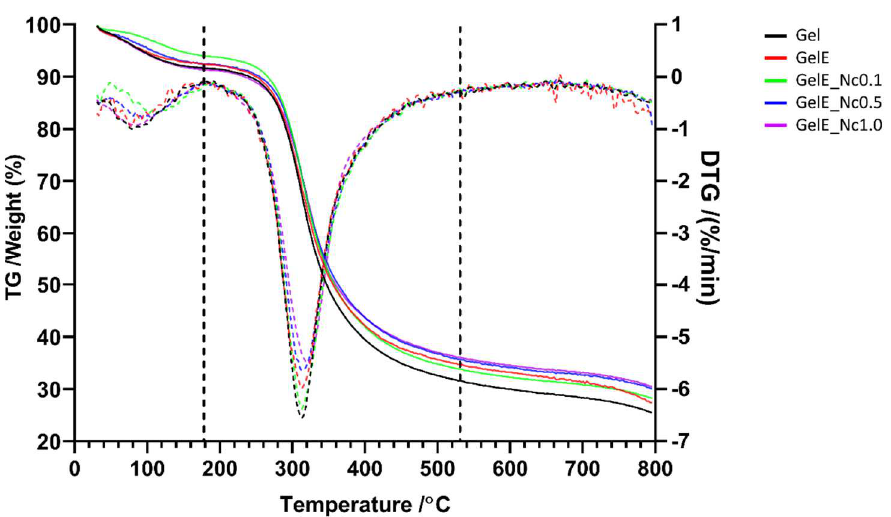
Figure 5. TGA thermogram and DTG curve. Full lines represent the TGA thermogram, showing weight loss for each scaffold as a function of temperature. Dashed lines represent the DTG curve, showing the rate of weight loss for each scaffold as a function of time. Composite scaffolds in general have better thermal resistance compared to the control groups.